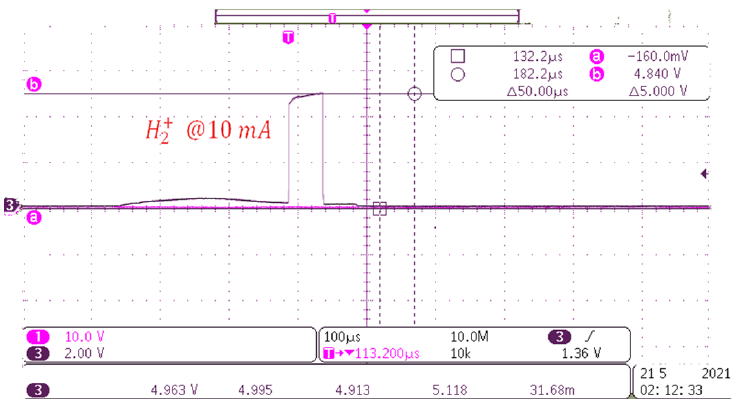
Figure 16. 10 mA 2 H + beam at the RFQ exit ACCT.